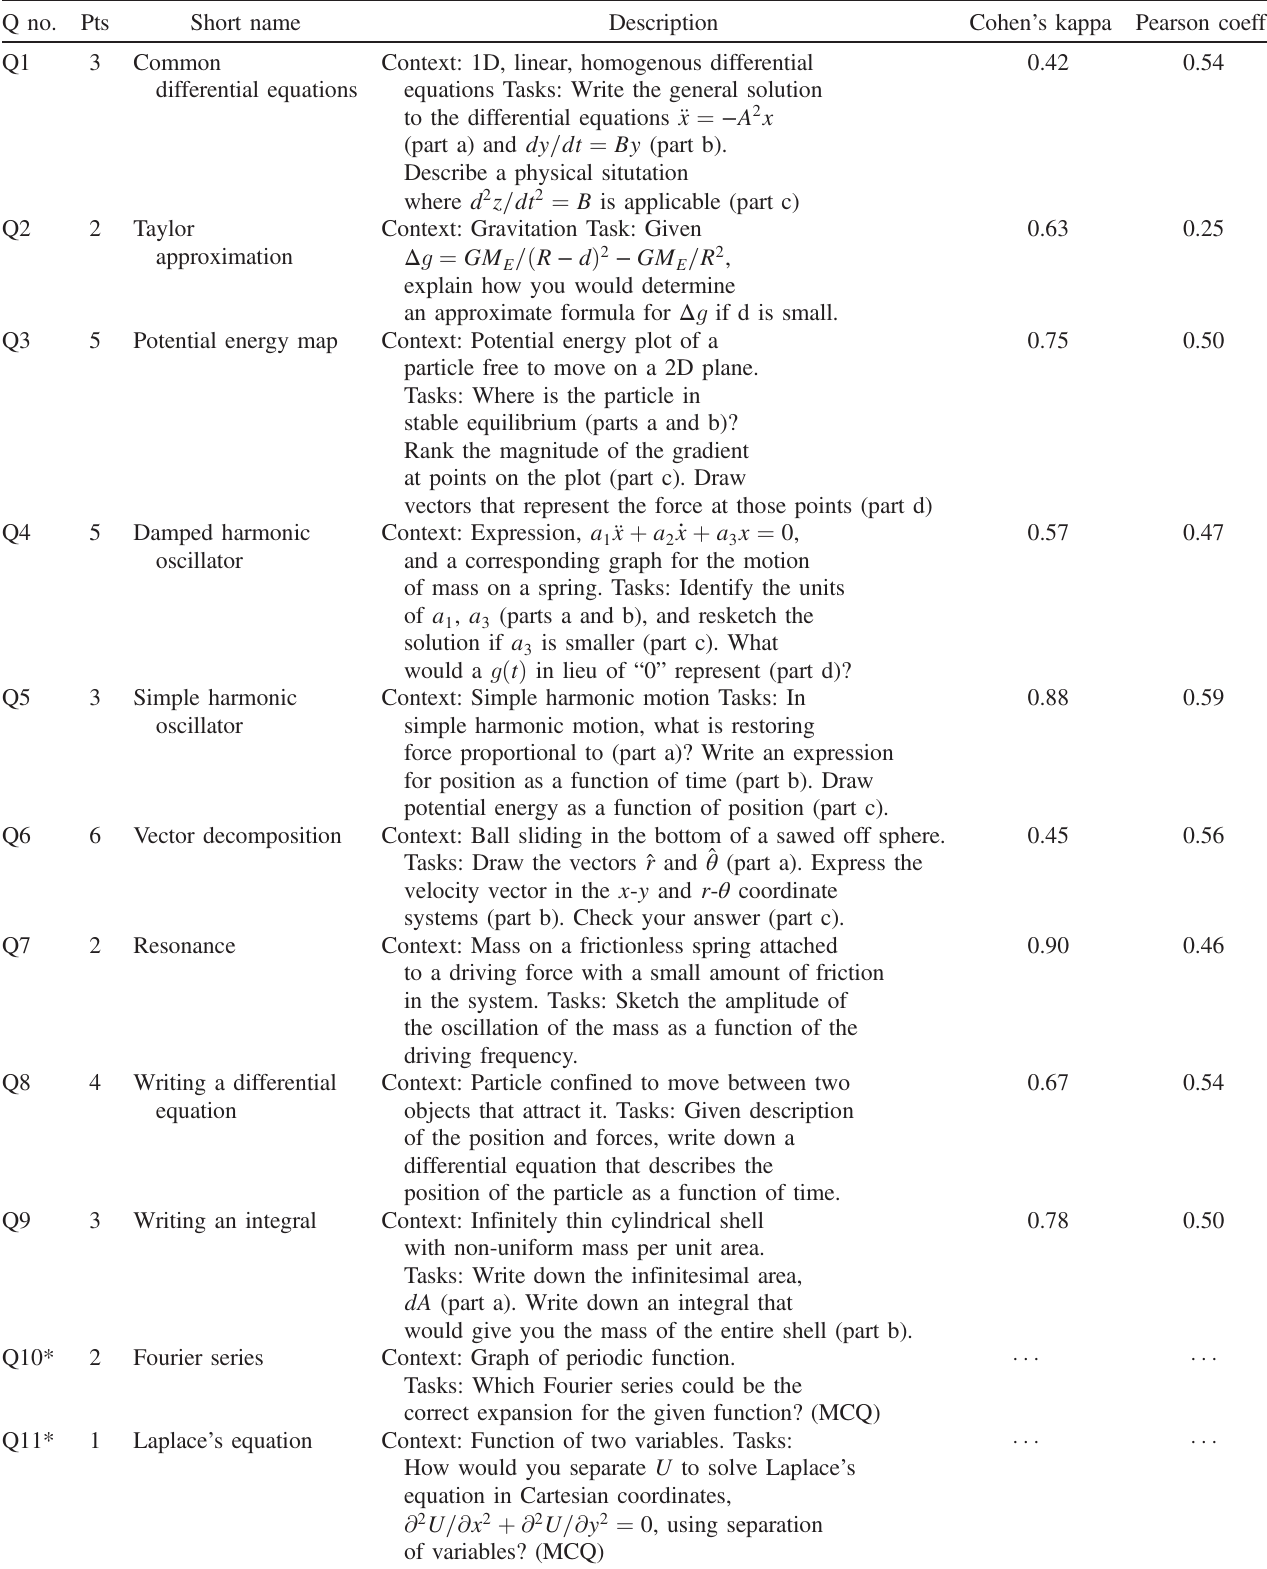
TABLE I. Questions appearing on the CCMI. The full instrument is available online [38]. Questions 10 and 11 are both optional (*) and multiple-choice questions